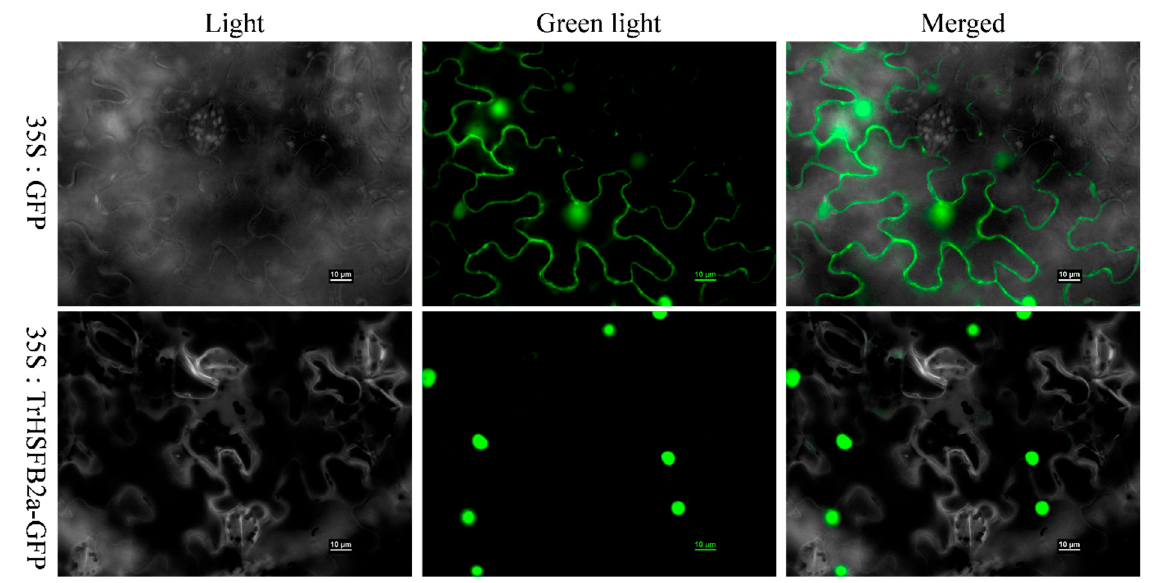
Figure 2. Subcellular localization of TrHSFB2a::GFP protein. The TrHSFB2a::GFP vector and an empty vector were transferred into tobacco leaves for transient expression and observed under the fluorescent microscope. Green color shows TrHSFB2a protein signals. Scale bar is 10 um.